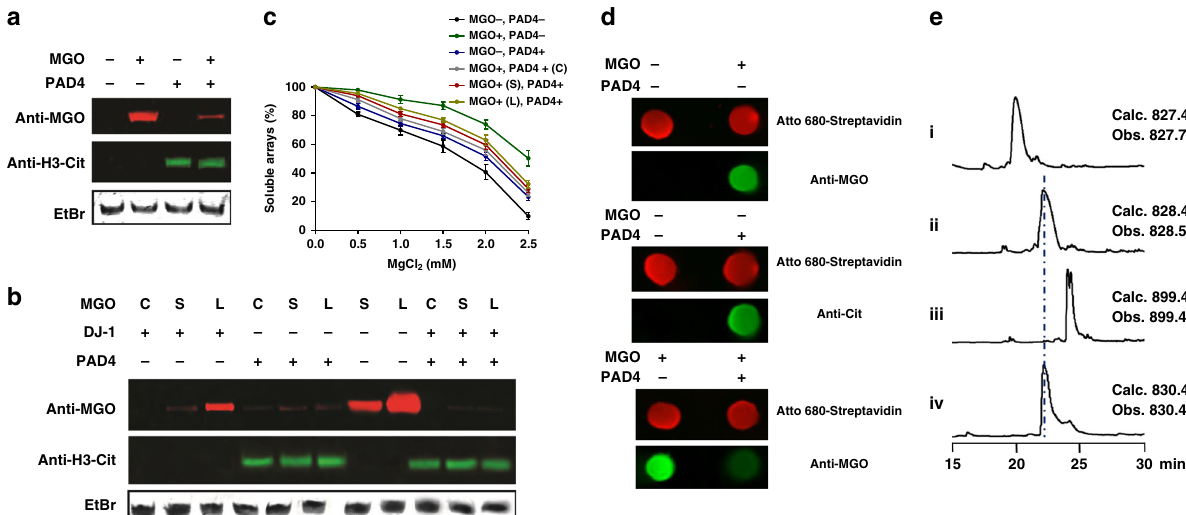
Fig. 2 In vitro citrullination and glycation assays. a NCPs were fi rst citrullinated by PAD4 followed by a 5 mM MGO treatment at 37 °C overnight. The reactions were separated on a native gel followed by a western blot analysis. ( b ) NCPs were pretreated with 5 mM MGO for short (S, 6 h) or long (L, overnight) periods and then incubated with PAD4, or concurrently (C) incubated with both the enzyme and MGO for the same time. c PAD4 was incubated with glycated nucleosomal arrays after short (S) or long (L) treatment with MGO, or co-incubation (C). Error bars represent the standard deviation from three different experiments. Data are presented as mean values± SEM. d Dot blot analysis of MGO glycation and PAD4-mediated deglycation on H3 N-terminal peptide substrate. The H3 peptide sequence is NH 2 -ARTKQTARKSTGGKAPRK(Bio)A-COONH 2 , and the biotin signal (imaged by Atto 680-Streptavidin) was used as loading control. e LC-MS analysis of modi fi ed and unmodi fi ed H4 peptides ( λ = 214 nm): (i) H4-R3(1-6) peptide, (ii) H4-Cit3(1-6) peptide, (iii) MGO-treated H4-R3(1-6), (iv) MGO-glycated H4-R3(1-6) followed by PAD4 treatment in H2 18 O. The H4 synthesized peptide sequences are AcNH-SGRGK(Bio)G-COONH 2 and AcNH-SGCitGK(Bio)G-COONH 2